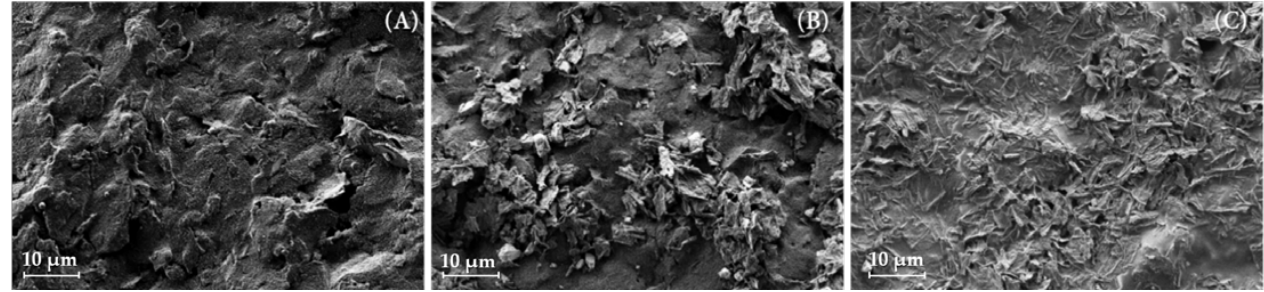
Figure 1. SEM images for ( A ) bare SPCE, ( B ) SPCE/N-htGONR/MnO 2 , and ( C ) SPCE/N- htGONR/MnO 2 /GOX are shown.